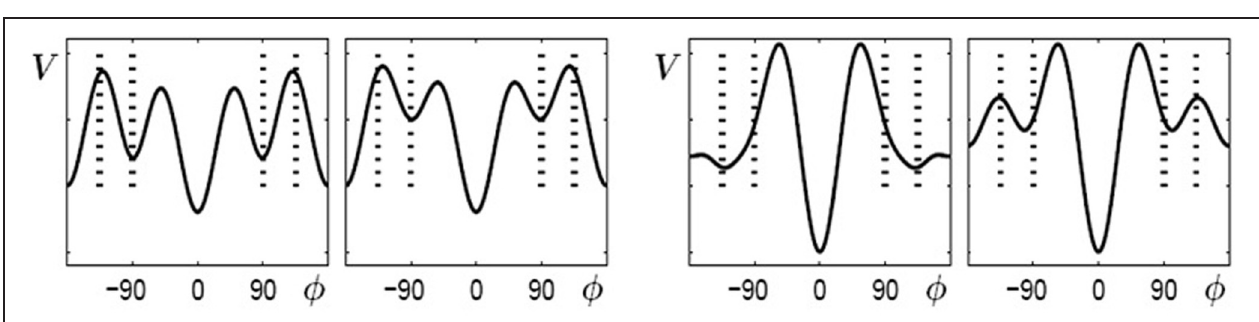
FIGURE 5 | Learning 135 ◦ for initially multistable participants. Top : potential landscape, V solid, V 1 ( λ ) dashed; bottom : phase space portrait; middle : bifurcation diagram. With increasing λ , the stable fixed point around 90 ◦ (solid line) drifts towards the repellor (dashed)